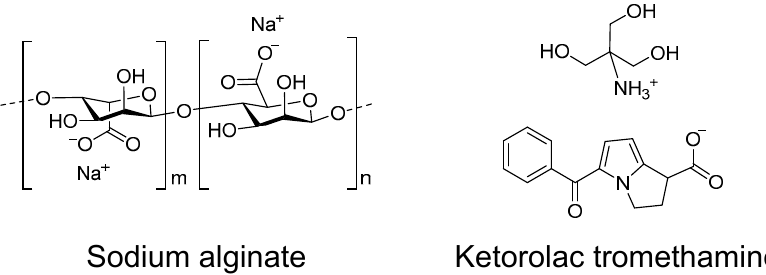
Figure 1. Chemical structures of sodium alginate polymer and ketorolac tromethamine.